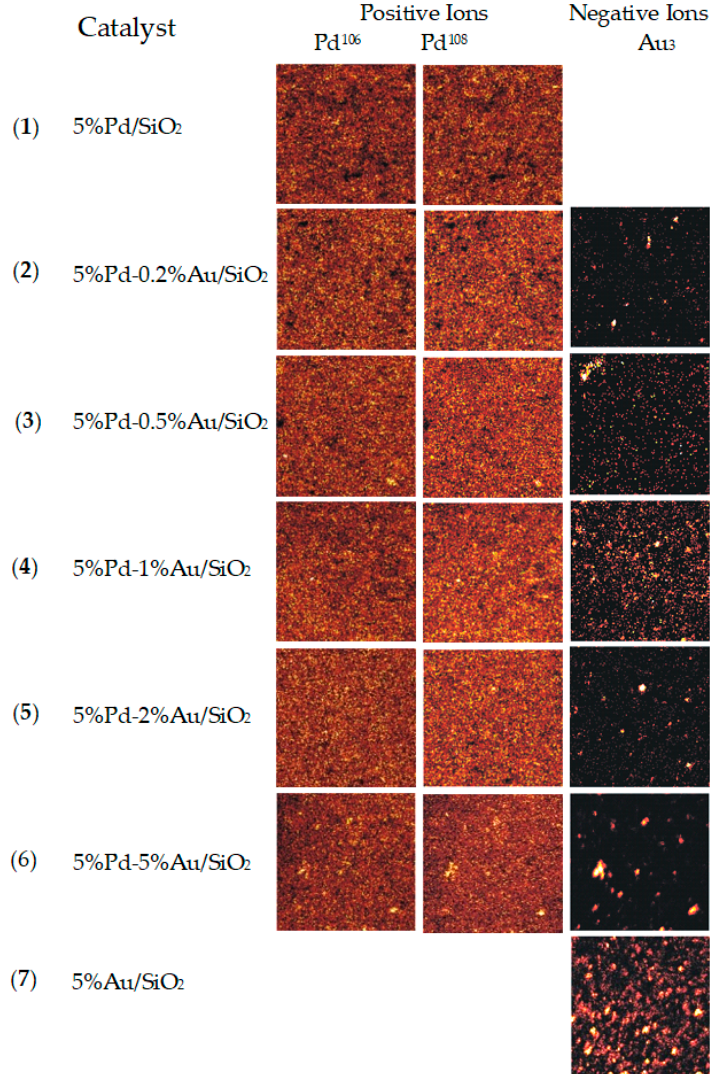
Figure 7. Secondary ions ToF-SIMS images of Pd / SiO 2 , Au / SiO 2 , and Pd-Au / SiO 2 catalysts after reduction in H 2 at 300 ◦ C. Images were recorded from 500 × 500 µ m area with an extreme crossover working mode of primary Ga + gun. Spatial resolution of images set to 128 × 128 pixels.